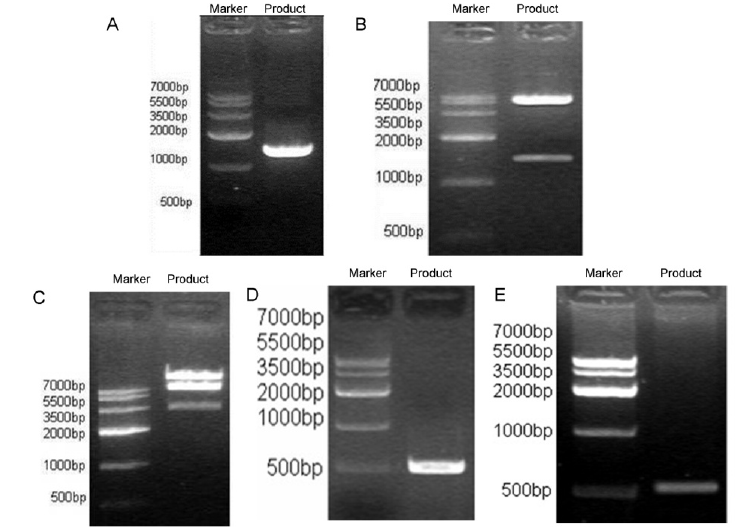
Figure 2. Recombinant adenoviral-mediated gene delivery to HEK293 cells. ( A ) The